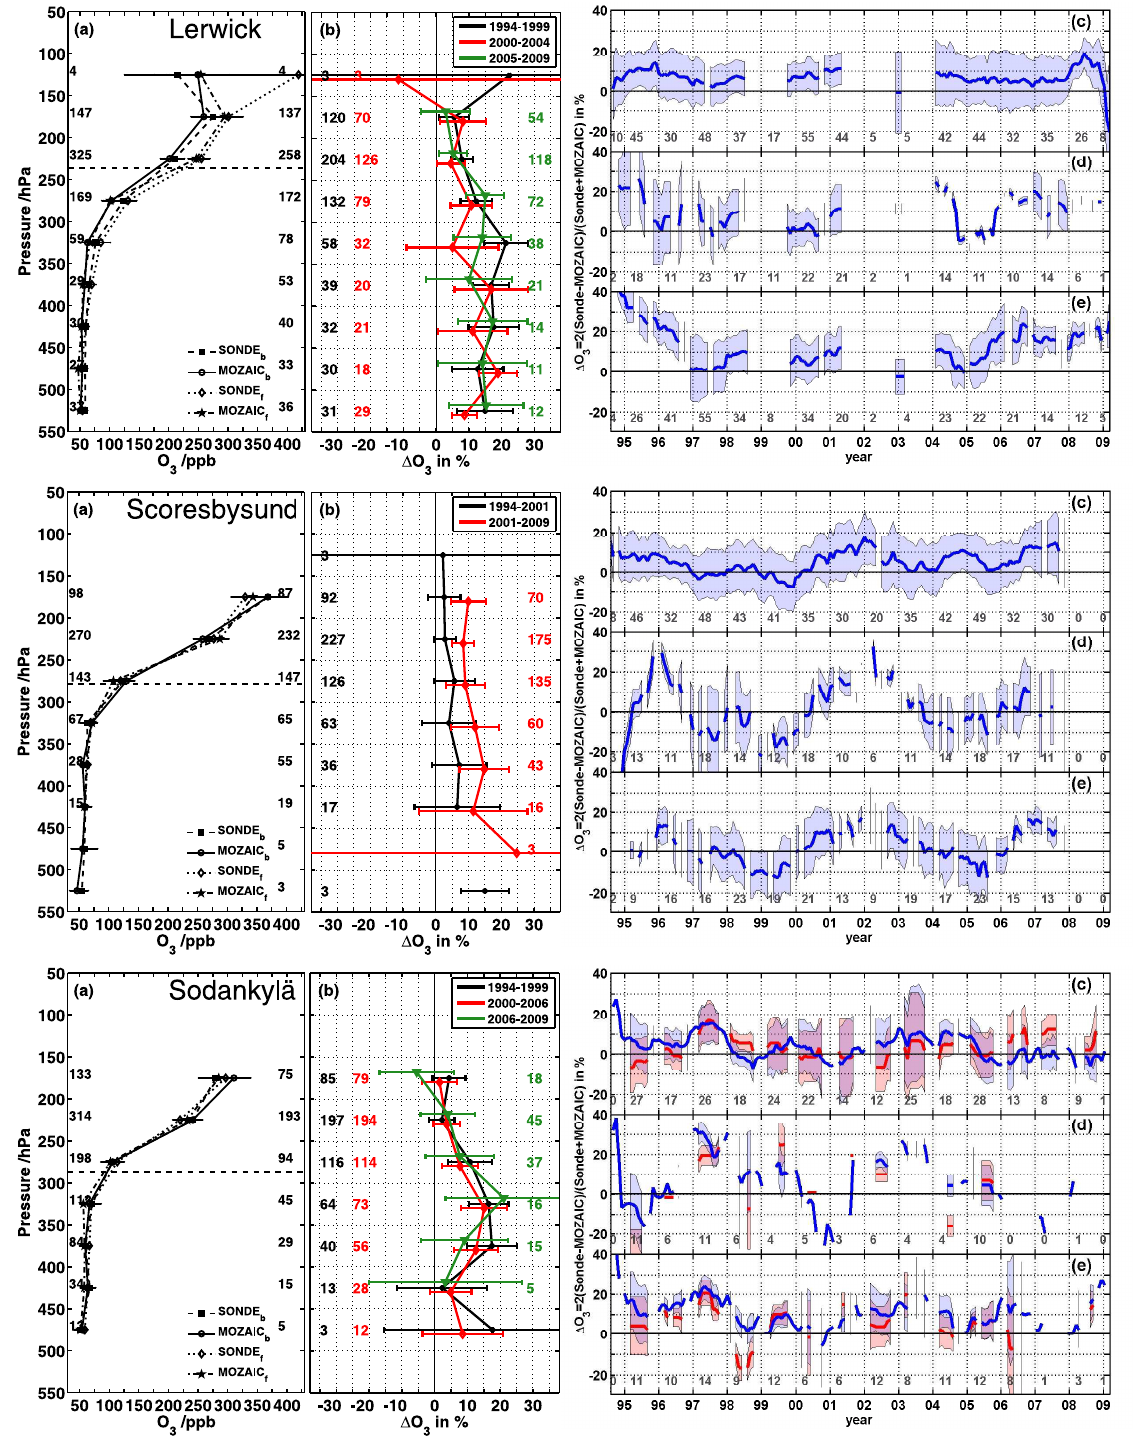
Fig. 11. Comparisons of ozonesondes and MOZAIC measurements. As for Fig. 3, but for Lerwick, Scoresbysund, and Sodankylä. Scoresbysund changed from SP to ES sondes in July 2001. The 1.0% KI was retained. Sodankylä mainly used SP sondes (1.0% KI) before switching to ES sondes (0.5% KI) in January